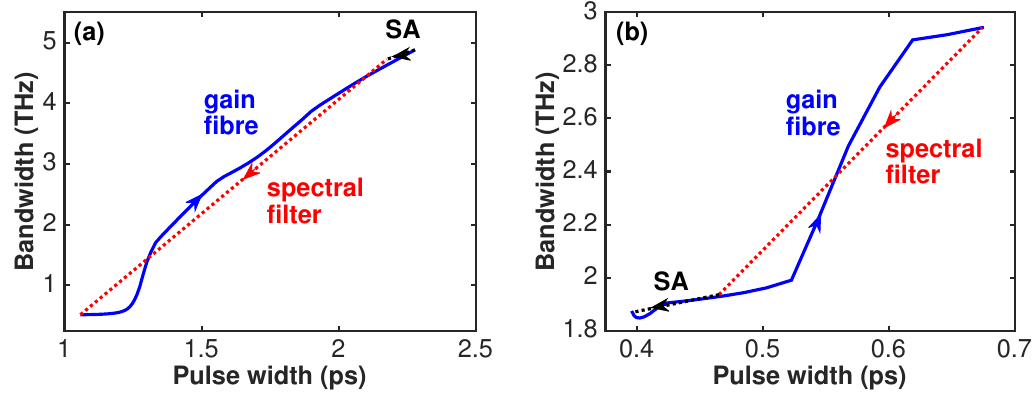
Figure 3. Phase diagrams representing the combined evolution of the FWHM temporal and spectral widths of the pulse over one round-trip in the cavity for: ( a ) a spectral pulse shaper with a triangular impulse response and a net cavity dispersion of 0 . 008 ps 2 ; ( b ) a = 0 . 5 ps) and in the absence of in-cavity flat-top spectral pulse shaper with B = 2 THz ( τ p dispersion